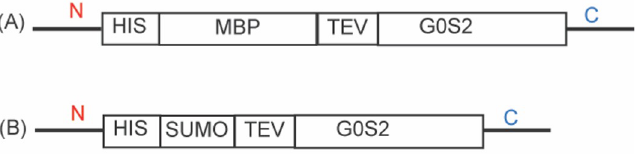
Fig 2. G0S2 construct design. MBP-G0S2 construct (A) contains 495 residues (54 kDa) whereas SUMO-G0S2 (B) is shorter with 214 residues (22.5 kDa). Both full length MBP-G0S2 and SUMO-G0S2 contain an N-terminal 6xHis-tag and a TEV cleavage site (ENLYFQ � S, where � indicates the cleavage site). Abbreviations: MBP, maltose-binding protein; SUMO, small ubiquitin-like modifier; TEV, Tobacco Etch